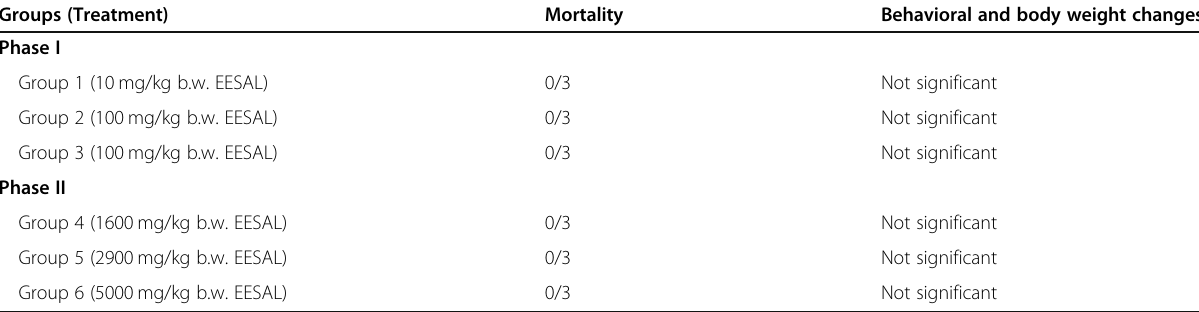
Table 2 Acute toxicity profile of the extract Groups (Treatment) Mortality